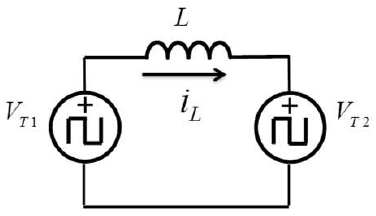
Figure 2. DAB simplified circuit.